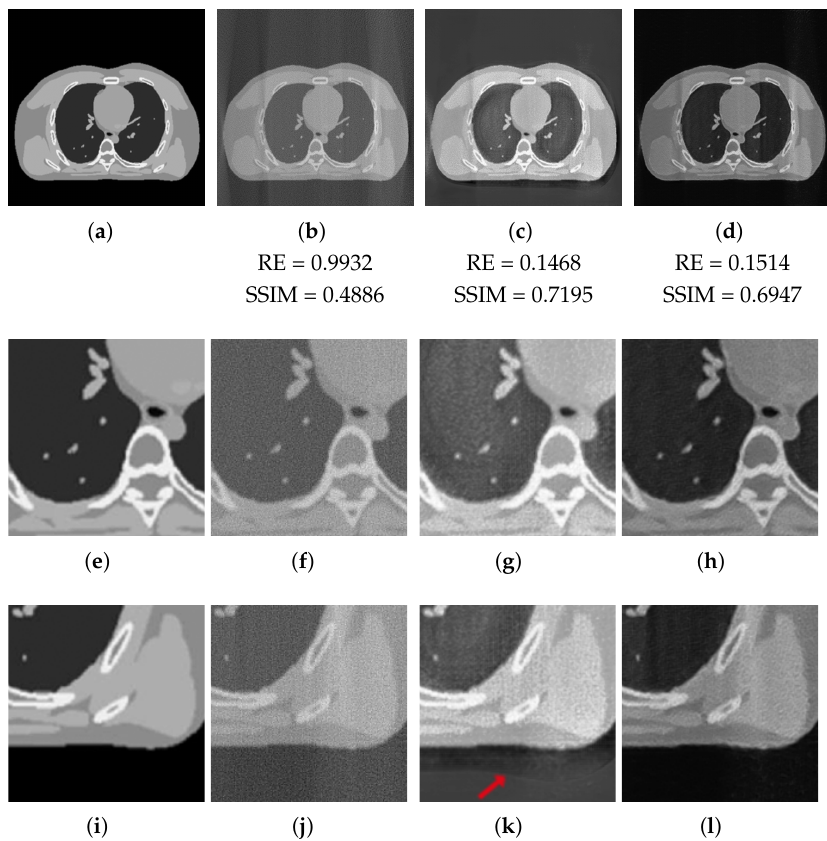
Figure 9. XCAT phantom test image with half-range geometry. From the left to right: ( first column ): Ground Truth image ( a ) and the considered zooms-in ( e , i ). Reconstructions from half-range geometry with FBP ( second column ), ResUNet ( third column ) and 3L-SSNet ( fourth column